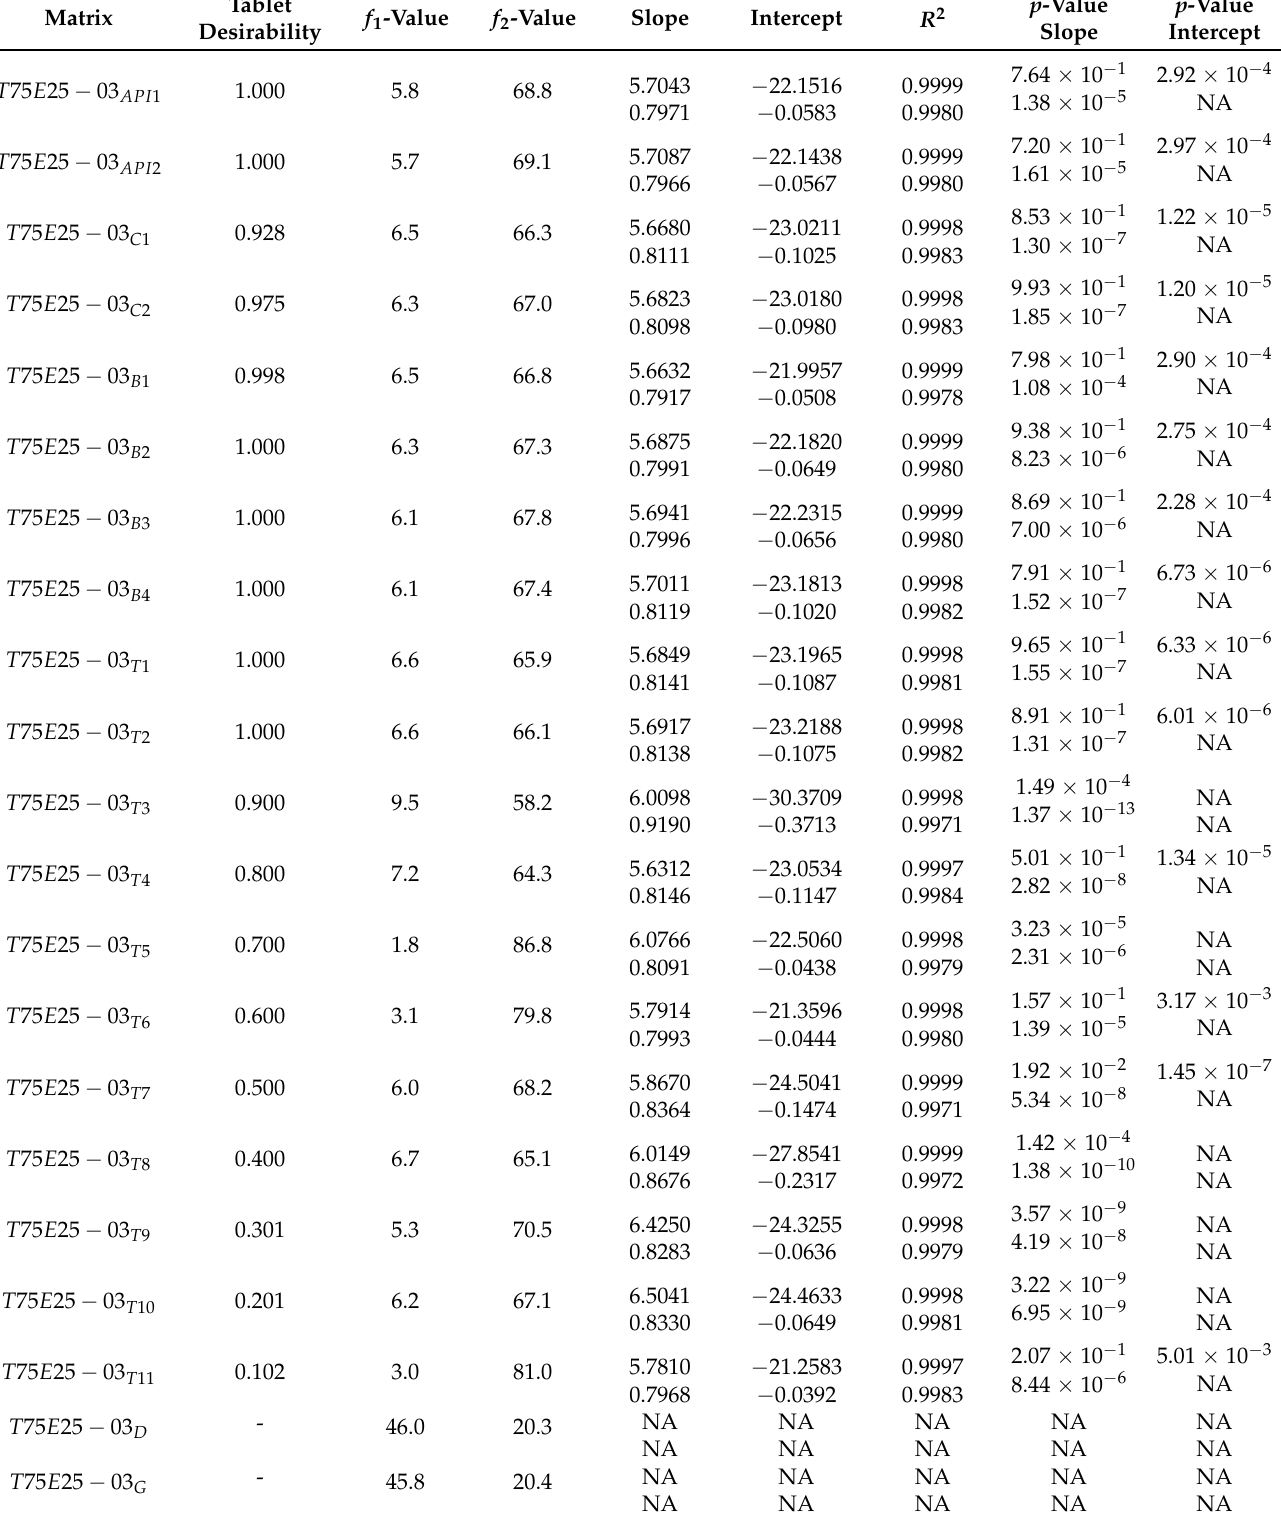
Table A5. The calculated results of the comparison of the predicted dissolution profiles and the experimental one. The first row in a cell is the value of the Higuchi plot, the second row represents the value of the Korsmeyers–Peppas plot. ’NA’ indicates that a value was not calculated because either there were too few data points or it was not necessary, e.g., if the slopes were significantly different, the p -value of the axis intercept was not